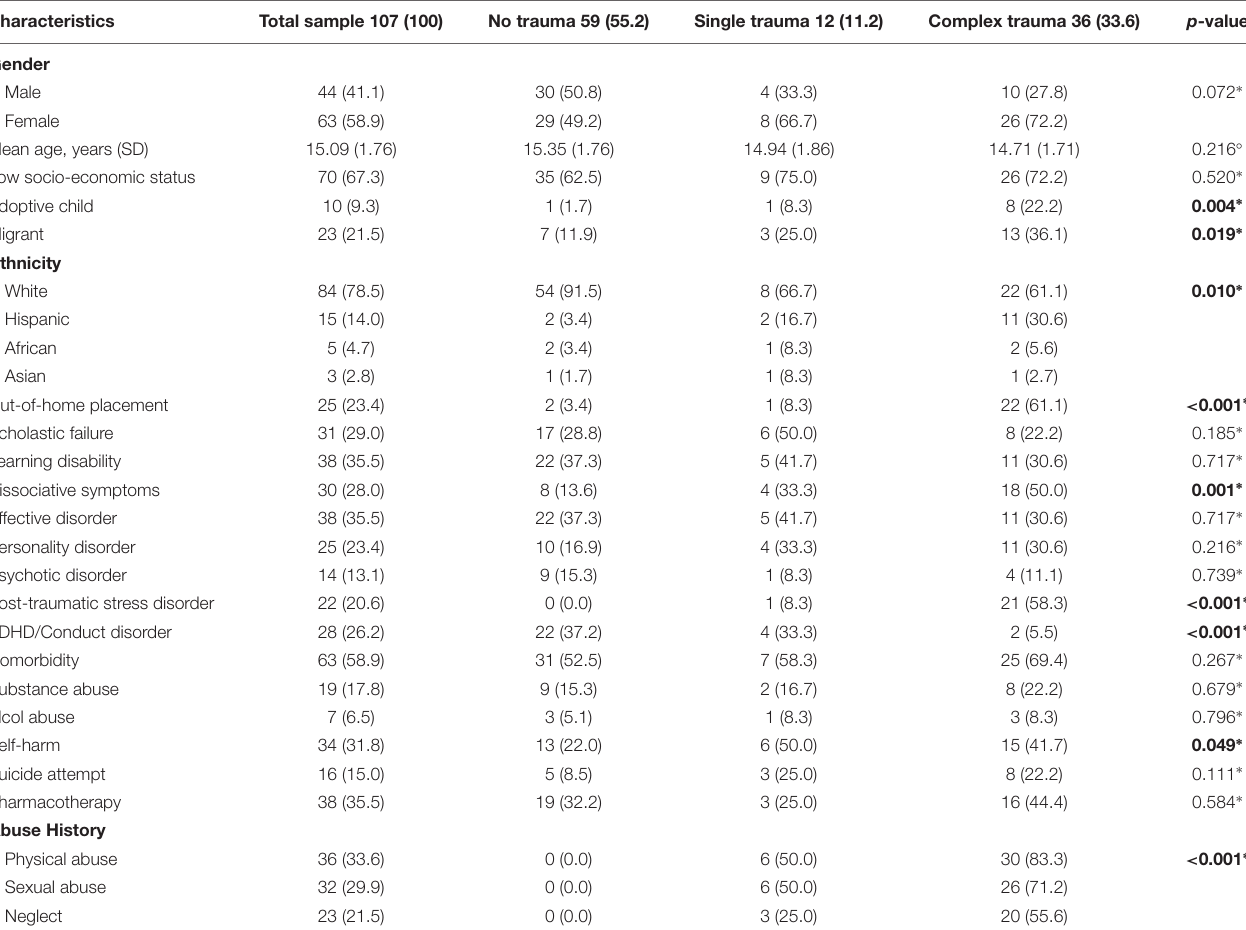
TABLE 1 | Demographic data and disease-related characteristics of the total